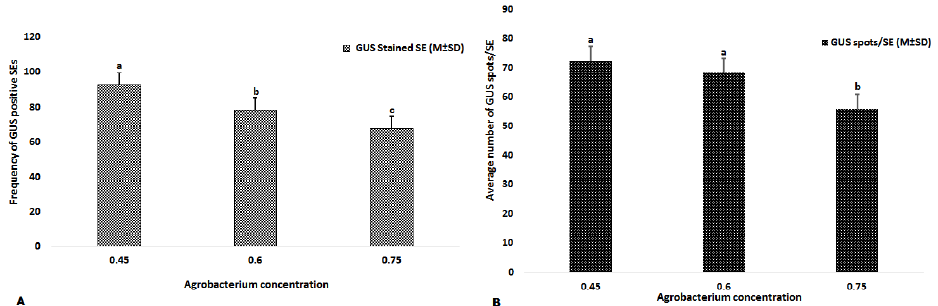
Figure 2. The effect of Agrobacterium concentration on frequency of transiently transformed SEs ( A ) and average number of GUS spots/SE ( B ) in Hevea . Results are expressed as mean (M) ± standard deviation (SD). The experiments were repeated three times. Means with the same letter above the bars were not significantly different at the 0.05 level according to Duncan’s t test. The SEs with deep GUS staining were termed ‘GUS-stained SE’.